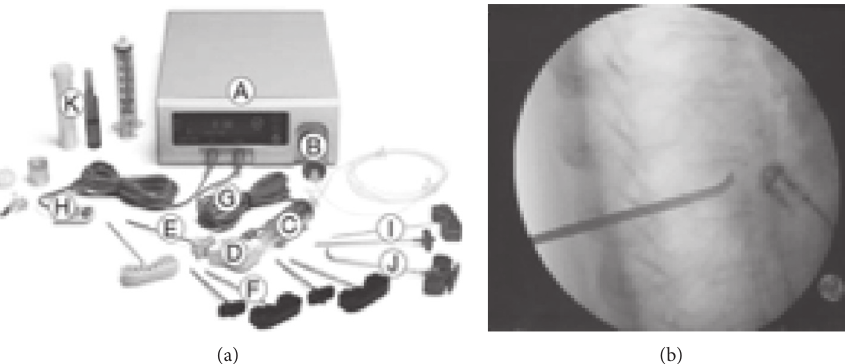
Figure 4: (a) Radiofrequency device and application system: (A) multiplex controller, (B) hydraulic assembly, (C) master syringe, (D) activation element, (E) locking delivery cannula, (F) StabiliTintroducer-working cannula and stylet, (G) activation element cable, (H) hand switch cable, (I) straight line osteotome, (J) power curve navigating osteotome, and (K) StabiliT ER2 bone cement [52]. (b) Intraoperative X- ray of L1 vertebra (lateral view) using RFK [52].